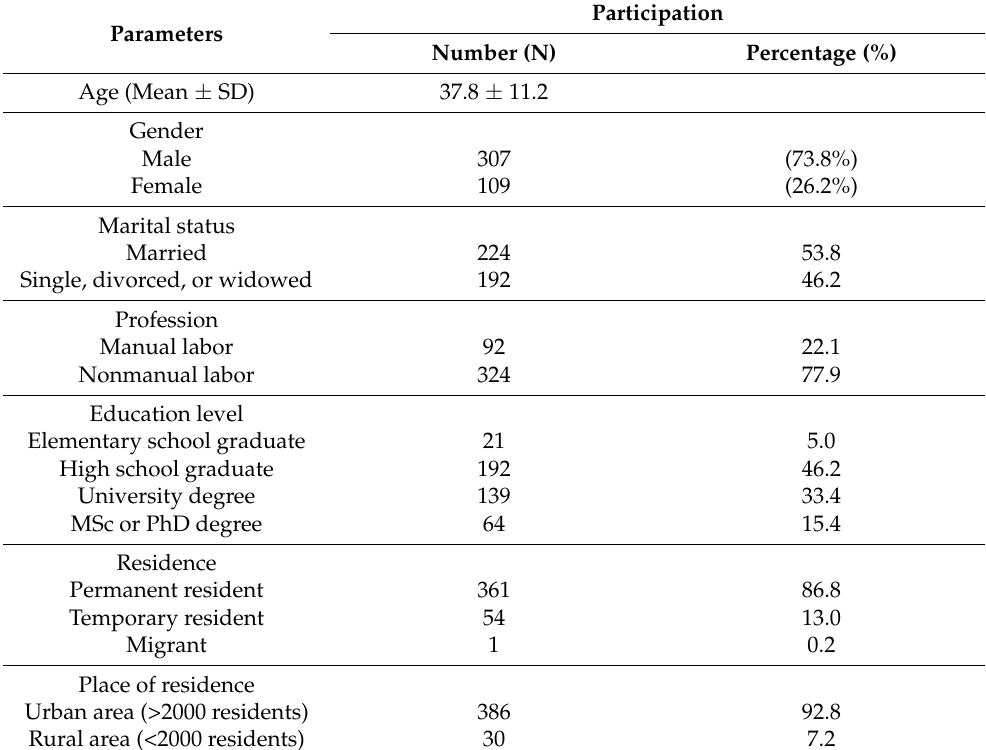
Table 1. Demographic data.